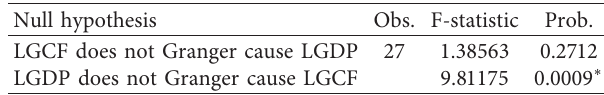
Table 7: Granger causality test